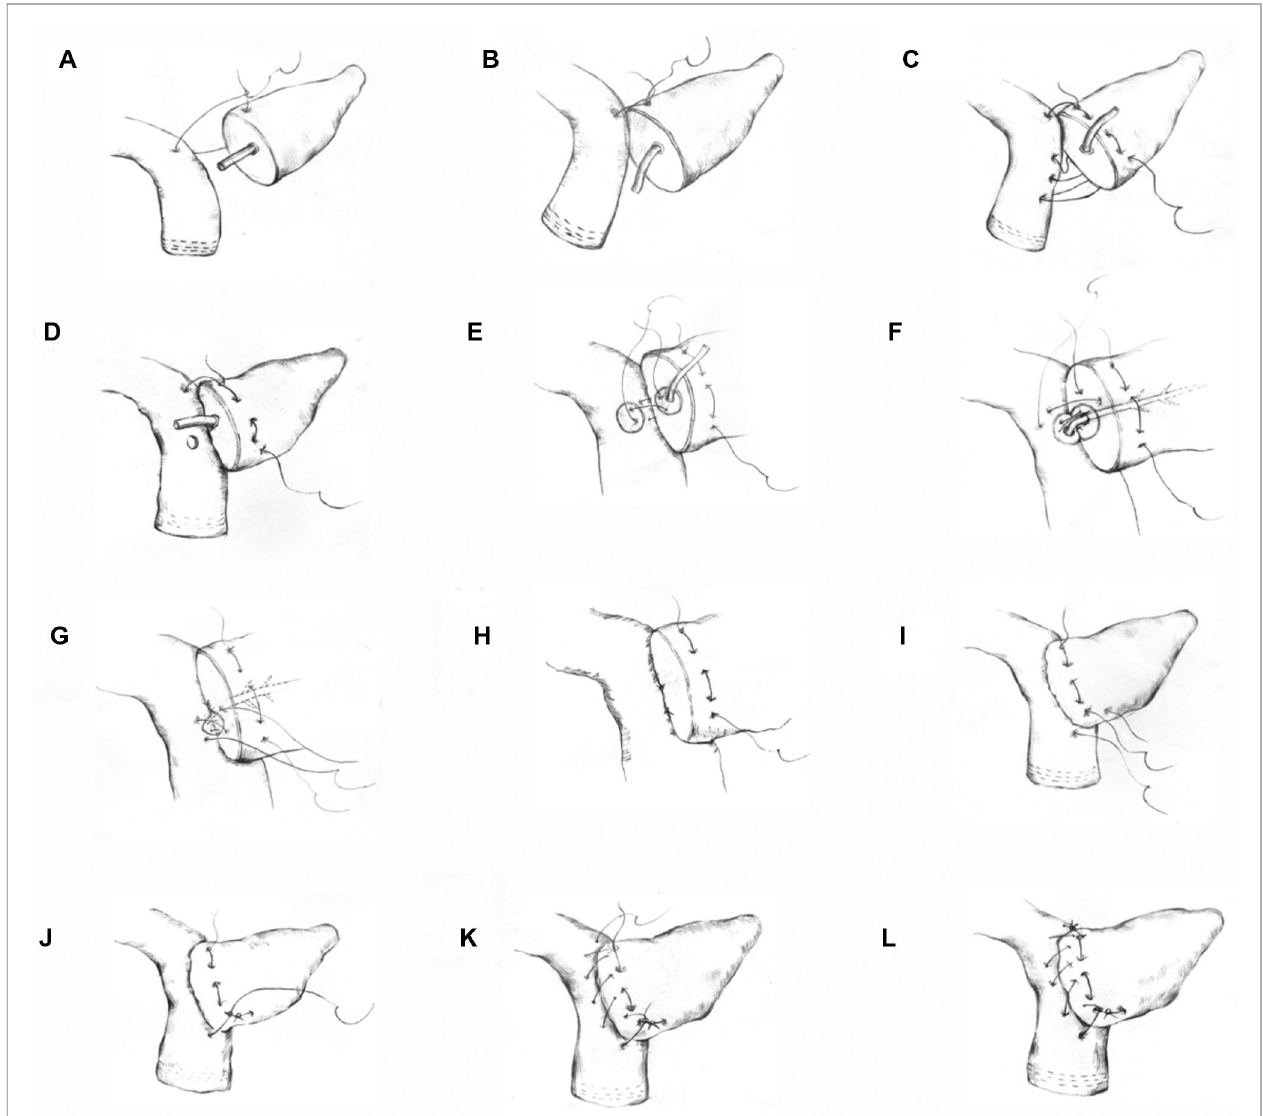
FIGURE 1 | Schematic diagram of the modi fi ed Blumgart anastomosis. Step 1 ( A – D ): suturing of the posterior wall of the pancreas and jejunum. In steps ( A,B ) the superior border of the pancreas was penetrated. Then, the seromuscular layer of the jejunum was sutured and knotted. Step c shows the suturing and fi xing of the superior border of the pancreas from the top to bottom through the entire pancreas and the suturing of the jejunum. Step 2 ( E – H ): the 8-shaped pancreaticojejunostomy anastomosis suture. Step ( D ) shows a small opening on the jejunum side made for the anastomosis. Step ( E ) shows the fi rst 8-shaped stitch on the posterior wall of the pancreaticojejunostomy. Steps ( F,G ) show the 8-shaped sutures of the second and third stitches. Step ( I ) shows that the inferior border of the pancreas was penetrated through the complete layer. Then, the seromuscular layer of the jejunum was sutured and knotted with the unknotted suture in Step 1. Step 3 ( K,L ): the anterior wall of the pancreas was sutured with the seromuscular layer of the